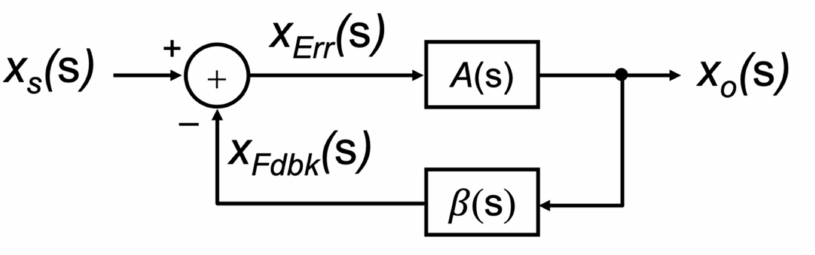
Figure 1. The general form of a negative feedback structure, as first proposed by H.